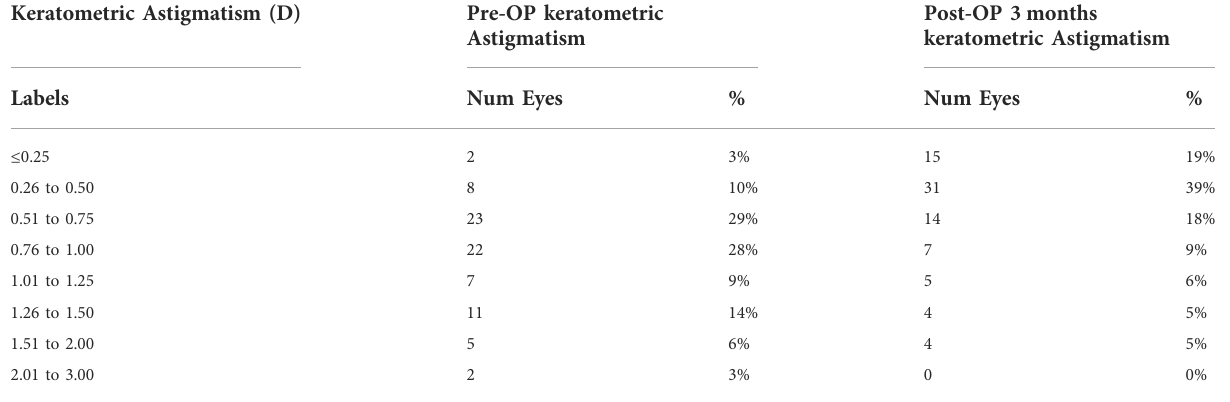
TABLE 2 Percentage of eye within certain levels of corneal astigmatism measured by Pentacam ( n = 80). Keratometric Astigmatism